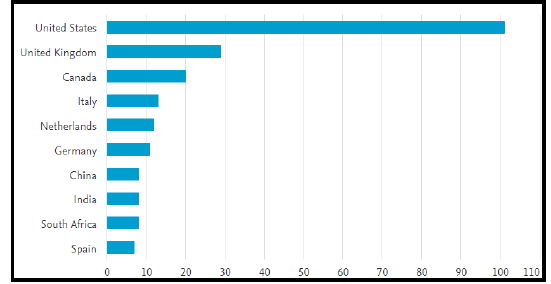
Figure 2: Number of published papers related to water quality and citizen science by Country (Elsevier, 2019)